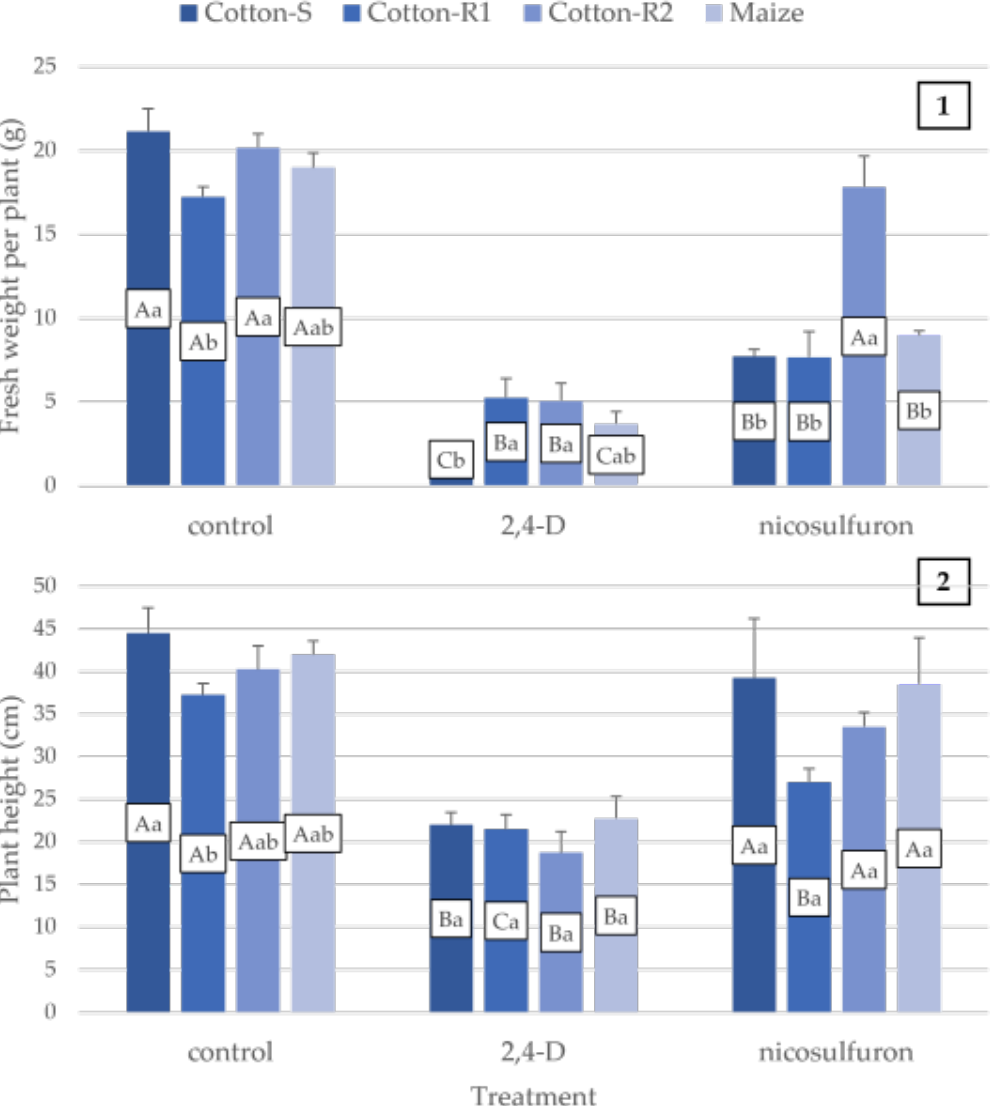
Figure 3. Fresh weight per plant ( 1 ) and plant height ( 2 ) at 21 DAT for the three A. palmeri biotypes from cotton and the one from maize. Vertical bars indicate standard errors of the means. The different uppercase letters (A, B and C) indicate significant differences between the treatments in the same biotype. The different lowercase letters (a and b) indicate significant differences between the biotypes for a specific treatment. Both analyses were carried out after the means separation, using Fisher’s least significant difference (LSD) test at p ≤ 0.05.